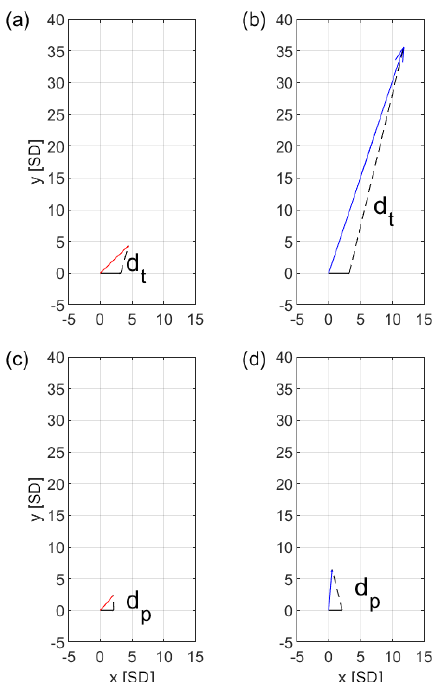
Figure 7. (a) The temperature distance between GLENS (black) and EQ (red), (b) the temperature distance between GLENS (black) and RCP8.5 (blue), (c) the precipitation distance between GLENS (black) and EQ (red), and (d) the precipitation distance between GLENS (black) and RCP8.5 (blue), shown on the 2-D plane that contains both area-weighted vectors (while both vectors are m - dimensional, there is a unique plane that contains both). Both tem- perature and precipitation are expressed in the number of stan- dard deviations (and are thus dimensionless). In each plot, both the x and y axes are distances in the number of standard deviations. In panels (a) and (b) , SD is the standard deviation of 20-year aver- ages of temperature, calculated from the across-ensemble variabil- ity from 2010–2029 in RCP8.5 simulations. In panels (c) and (d) , SD is the standard deviation of 20-year averages of precipitation.